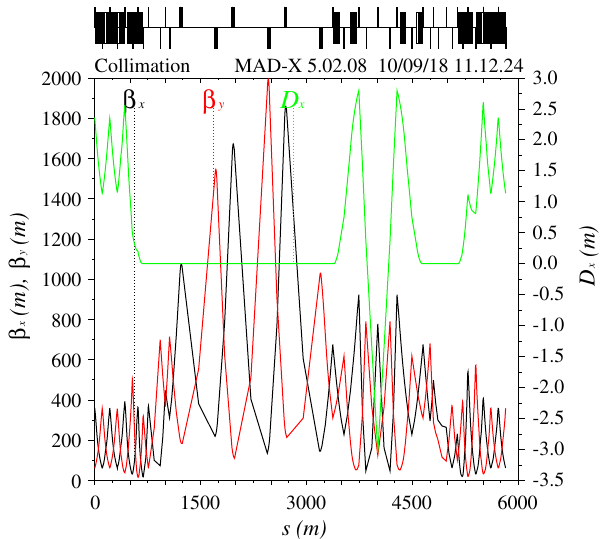
FIG. 2. The betatron and dispersive functions of the collimation insertion in lattice scheme I.